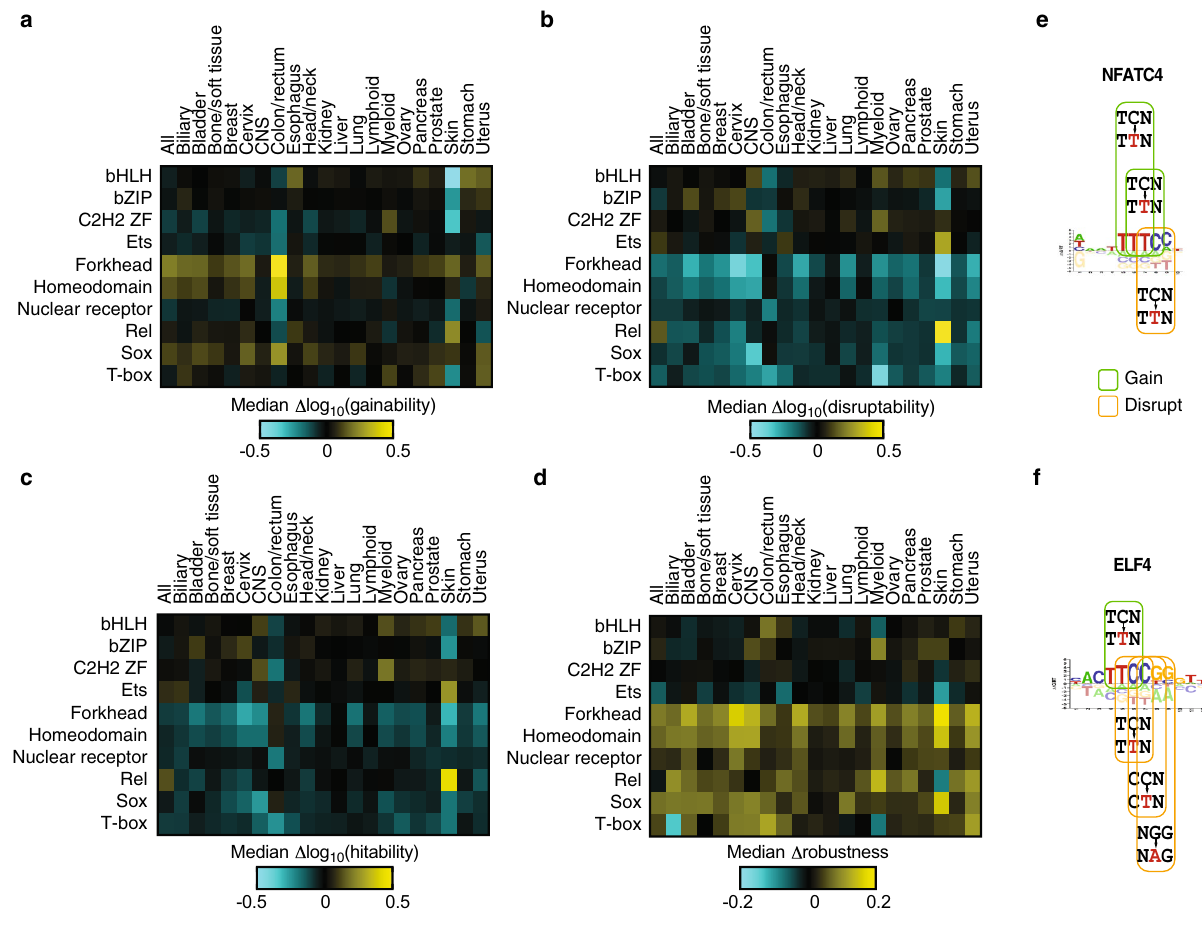
Figure 1. A correct version of the original Figure